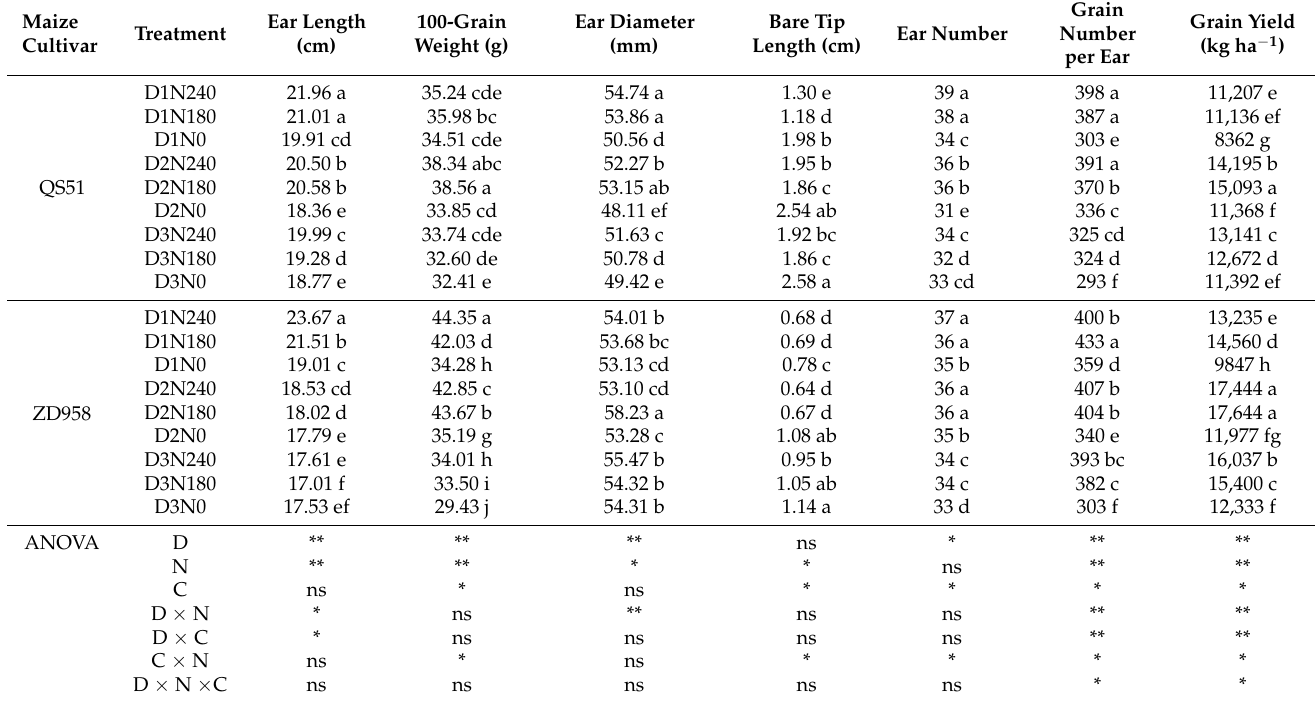
Table 3. Grain yield and its components for QS51 and ZD958 in